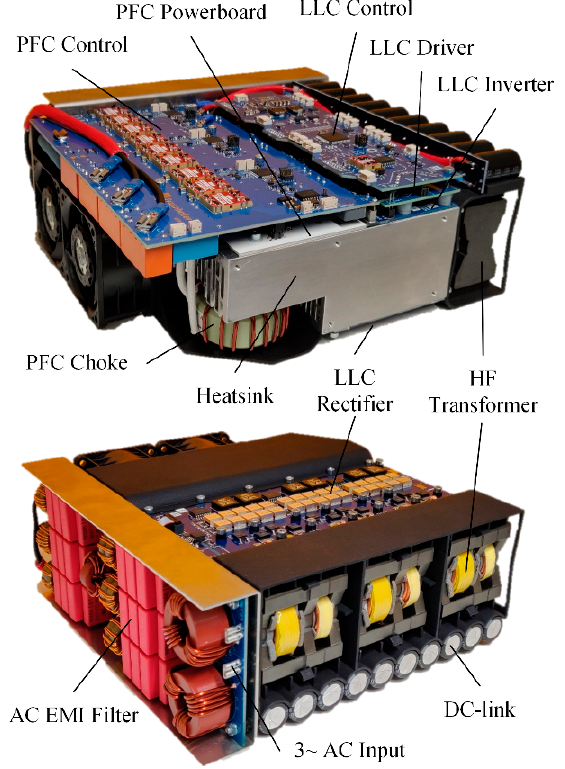
Figure 22. Prototype of the proposed portable off-board charger. The dc EMI filter is removed in the upper picture to provide a view of the PFC inductors and the hf transformers placed inside the heatsink.